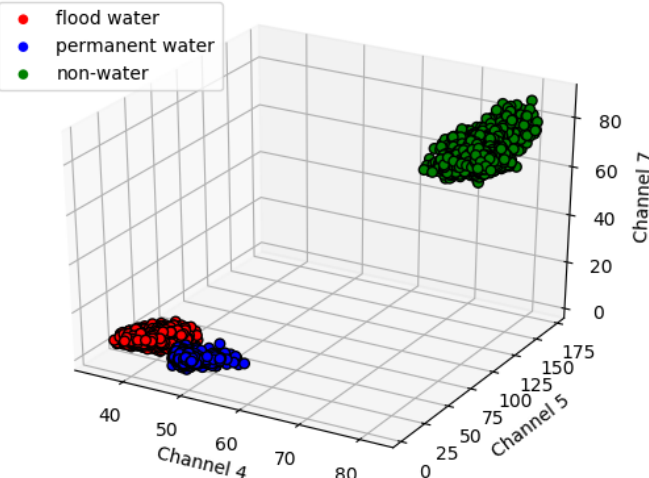
Figure 12. The scatter plot of class samples from test image-1 on a 3D graph. The axis represents channel-4, channel-5 and channel-7. The graph shows that even in the infrared region the spectral properties of flood water and permanent water are